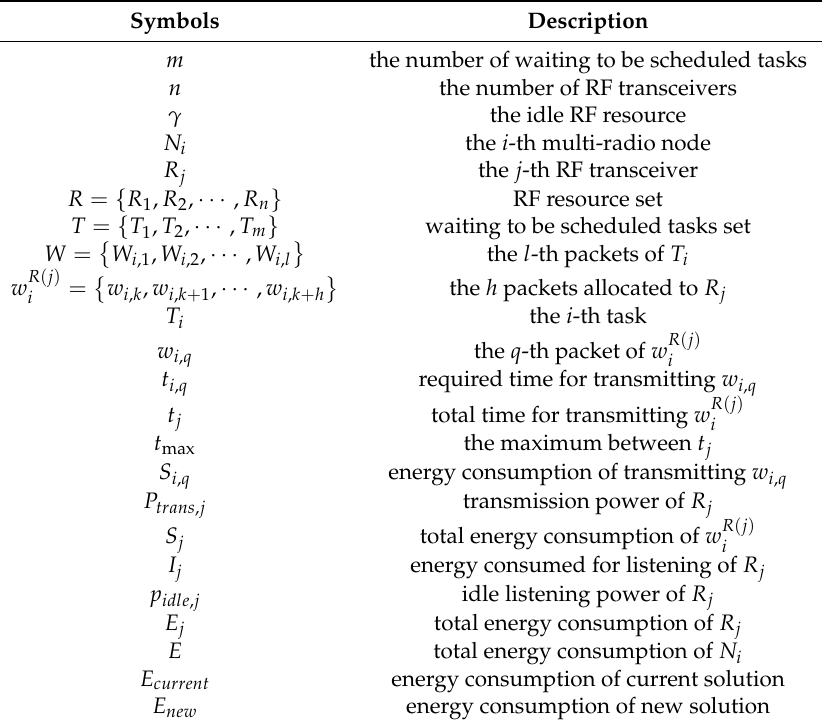
Table 1. Acronyms and parameters used in this